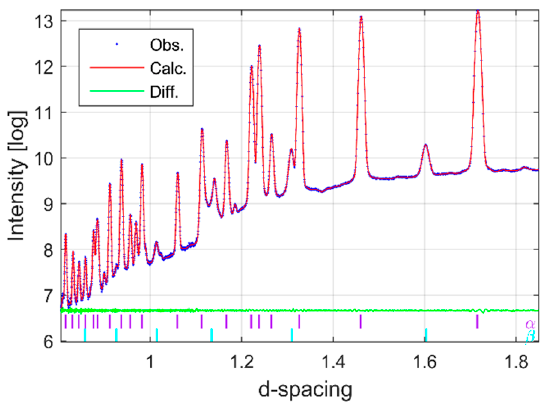
Figure 9. One typical Pawley refinement result: R wp 1.73, Goodness of fit (GOF) 1.52.